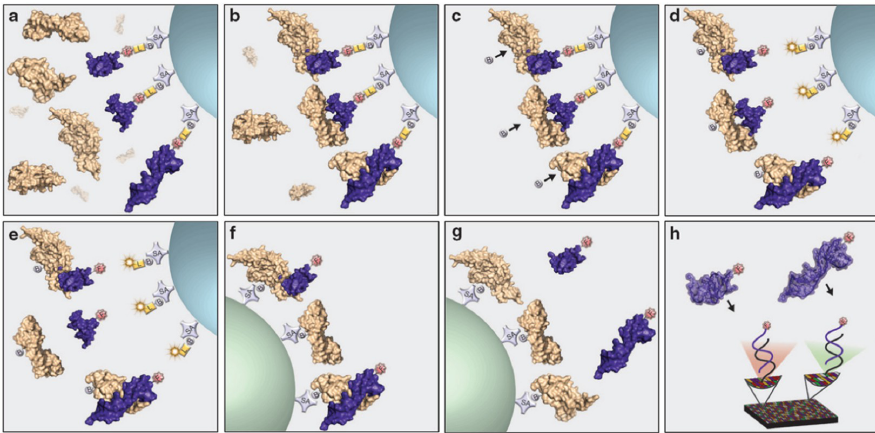
Figure 8. Schematic representation of the SOMAscan assay. Beige structure—protein in sample, purple structure—SOMAmer with a ffi nity for target protein, grey circle B—biotin on streptavidin (SA)-coated bead, yellow square L—photocleavable linker, red circle F—fluorophore. In this DNA microarray platform, 5 (cid:48) -biotinylated SOMAmers are modified with a photocleavable linker